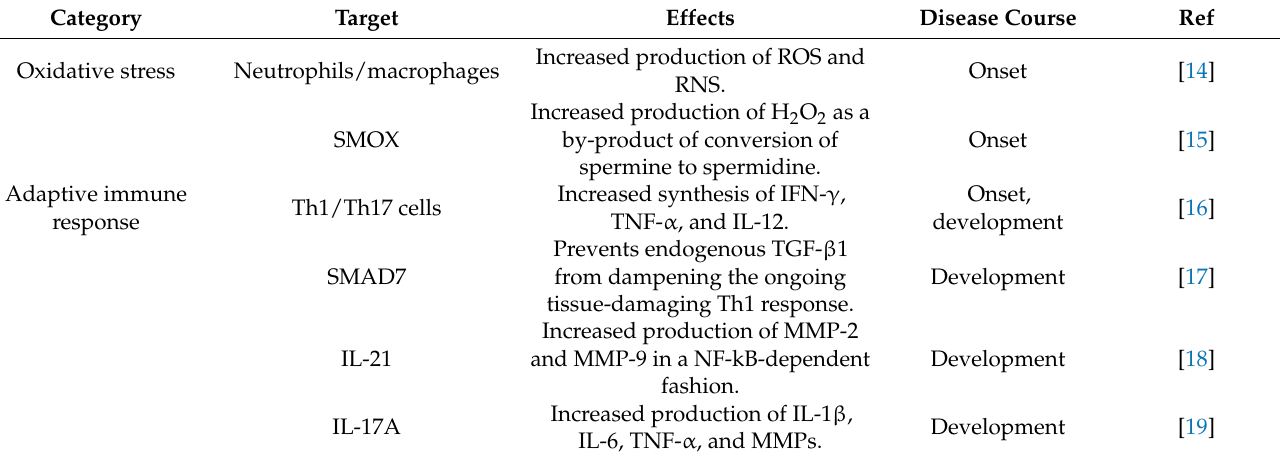
Table 1. Effects of H. pylori infection on tumor-promoting chronic